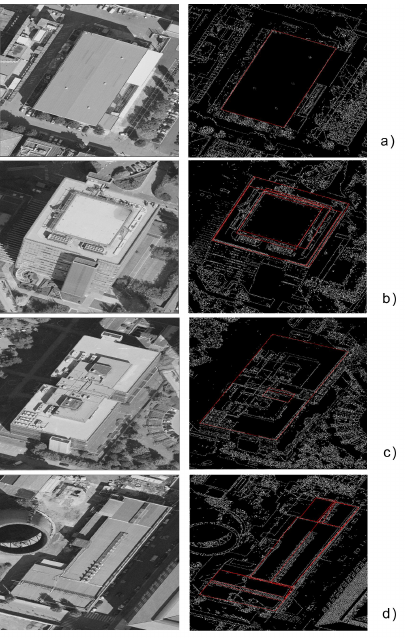
Figure 3: The results of buidings